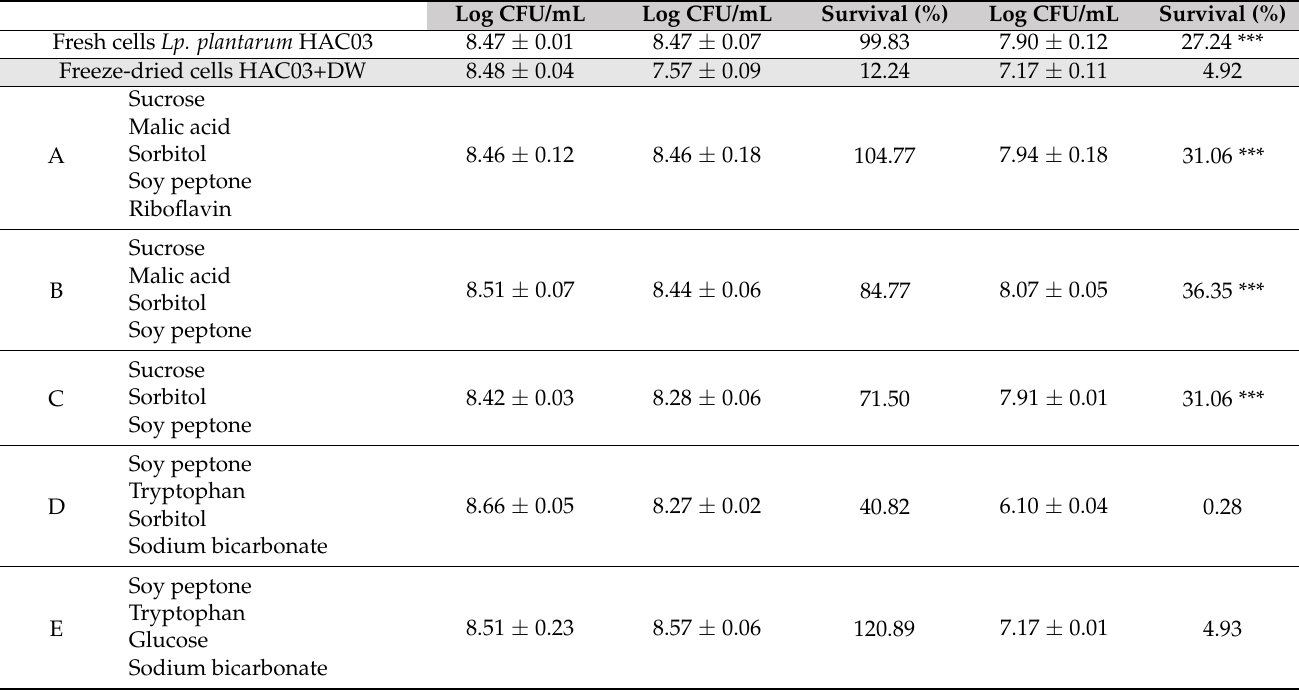
Table 1. Survival of freeze-dried Lp. plantarum HAC03 after passing the simulated environment of the GIT as a function of rehydration with five formulations containing different proportions of selected cell-protecting food